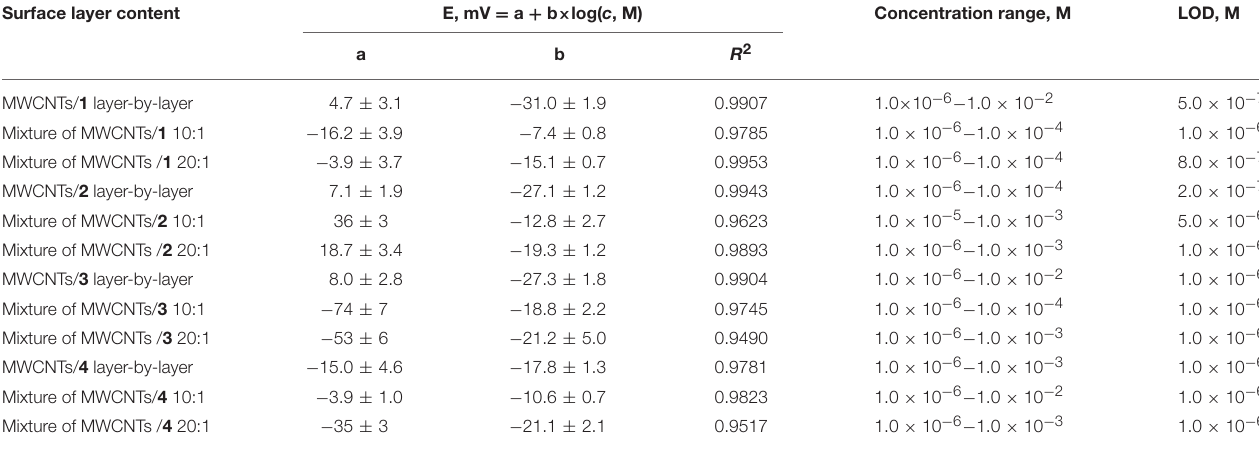
TABLE 2 | Analytical characteristics of hydrogen phosphate determination with solid-contact potentiometric sensor based on MWCNTs and IL 1 - 4 . Surface layer